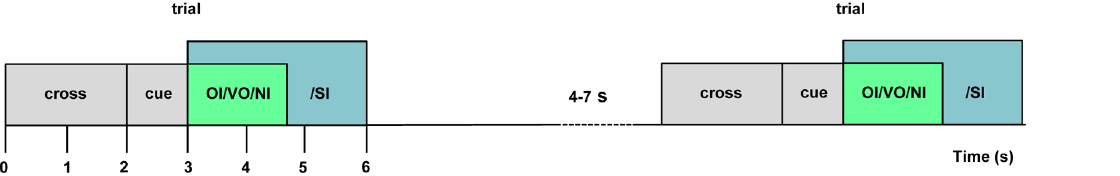
Fig 1. The experimental paradigm. At t = 0 s, a fixation cross is presented followed by a cue at t = 2 s. The cue stays until t = 3 s. Participants performs OI, NI, and VO from t = 3 s to t = 4.7 s. SI lasts from t = 3 s to t = 6 s.